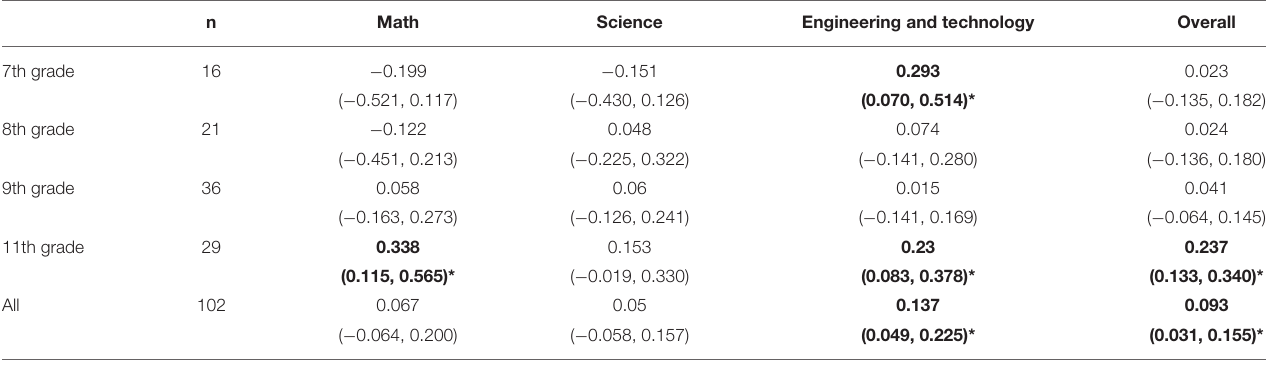
TABLE 2 | Shifts in positive attitudes and perceptions of